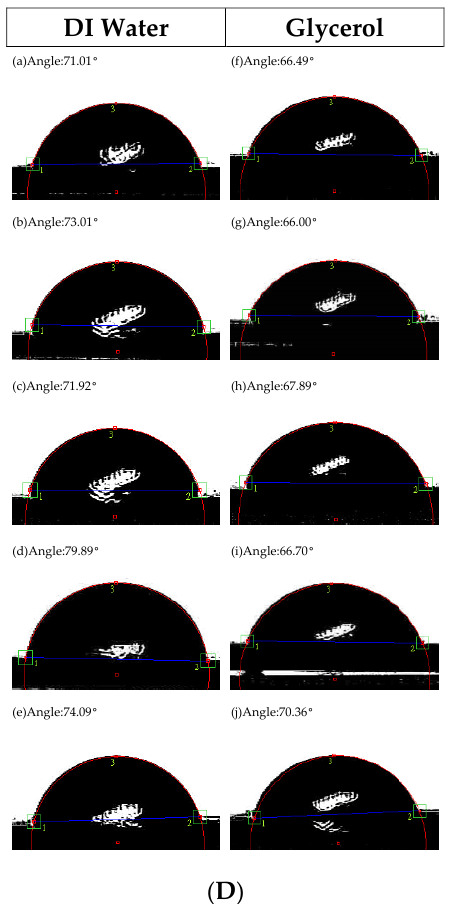
Figure 4. Contact angles of Co 40 Fe 40 Yb 20 thin films under four conditions: ( A ) RT, ( B ) after annealing at 100 °C, ( C ) after annealing at 200 °C, and ( D ) after annealing at 300 °C with DI water: ( a ) 10 nm, ( b ) 20 nm, ( c ) 30 nm, ( d ) 40 nm, and ( e ) 50 nm. Glycerol: ( f ) 10 nm, ( g ) 20 nm, ( h ) 30 nm, ( i ) 40 nm, and ( j ) 50 nm.